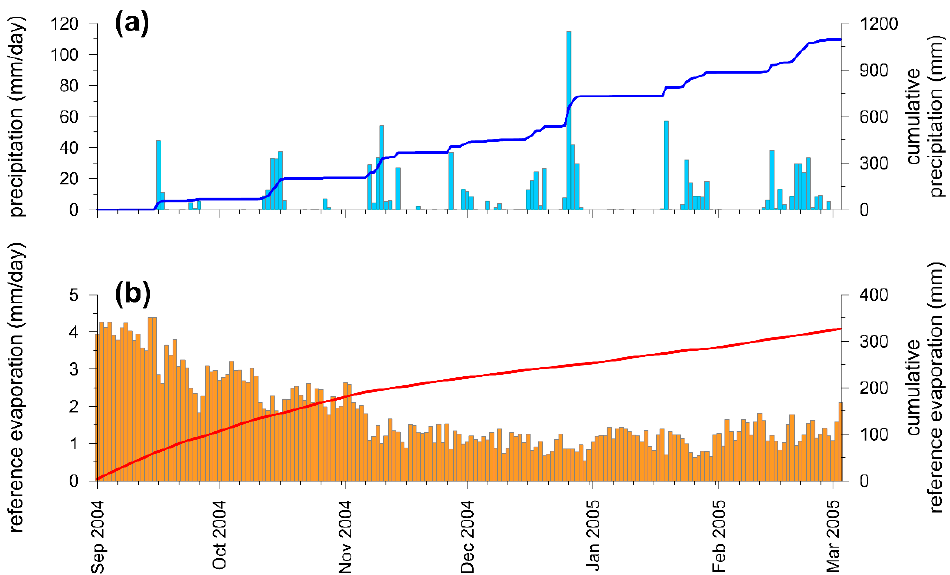
Figure 2. Evolution of antecedent meteorological conditions recorded within the study area during the landslide hydrological year: ( a ) daily precipitation and cumulative precipitation; ( b ) daily reference evaporation and cumulative reference evaporation.